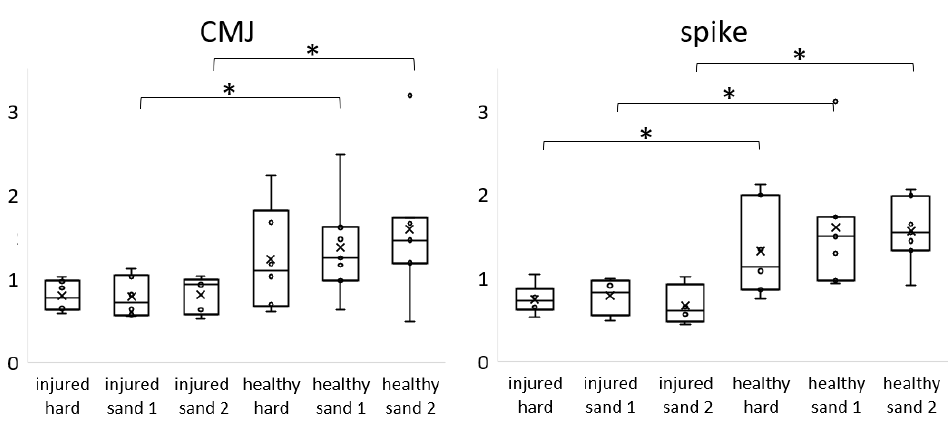
Figure 1. Box plots of VM/VL ratios of athletes with and without chronic knee pain on the leading leg. Ratios are displayed for all three surfaces: hard surface, sand 1, and sand 2. Significant group differences (α < 0.05) are marked with *. Individual VM/VL ratios are displayed as dots. The median values and interquartile ranges are also displayed in Table 2. Table 2. Median values and interquartile ranges in CMJs and spike jumps for the leading limb of healthy and unilaterally injured athletes. All unilaterally injured athletes had pain in their leading limb. Injured